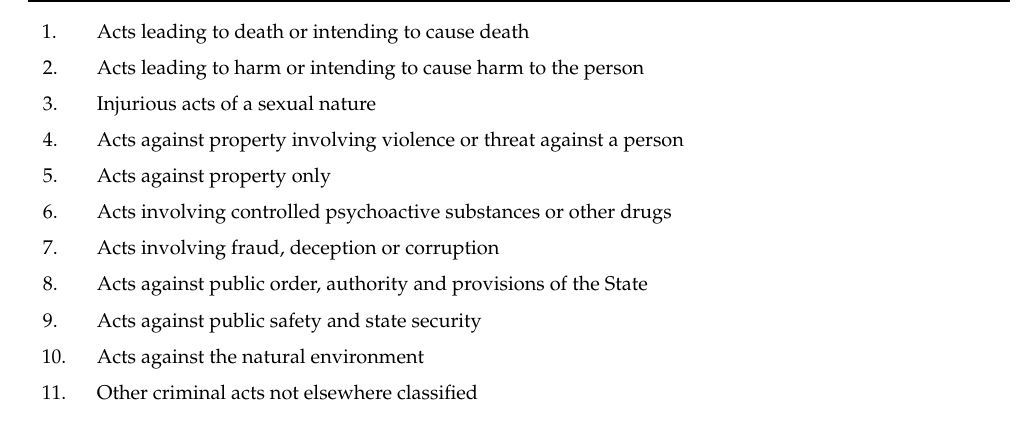
Table 2. UNODC Level 1 crime categories.